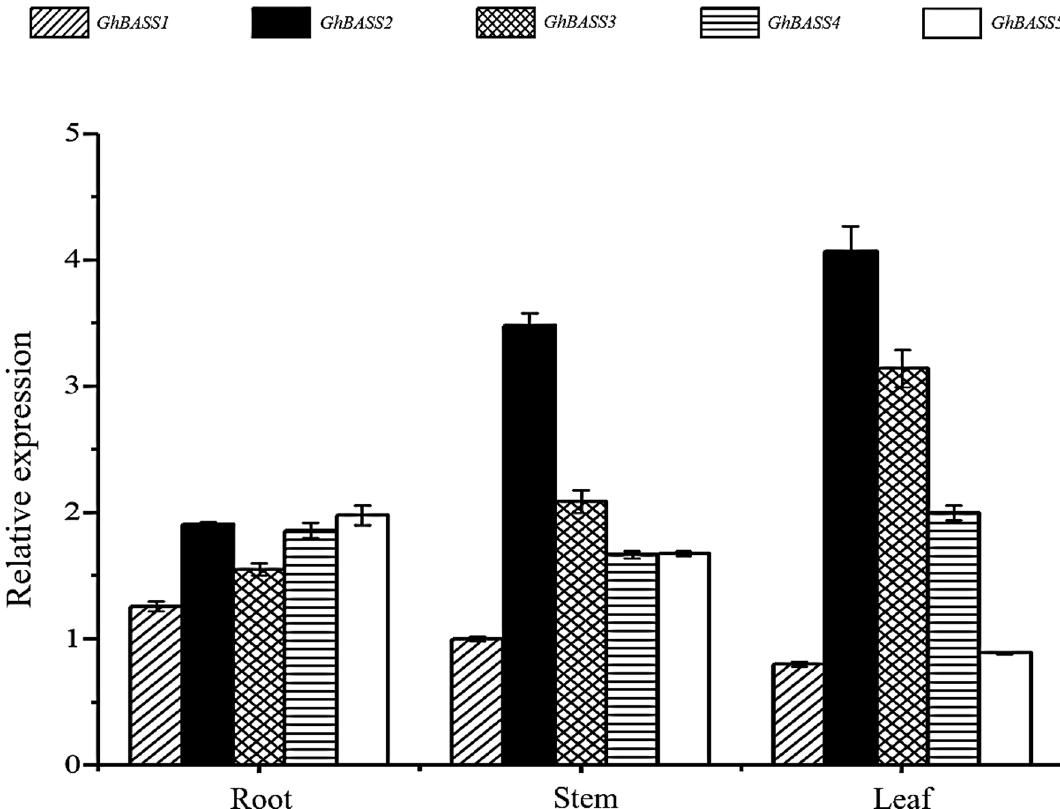
Figure 6. Expression patterns of GhBASSs in different tissues of cotton. Transcript levels were analyzed by qPCR and normalized to the GhUBQ7 gene (GenBank accession no. DQ116441). Means and standard errors were based on three idependent biological replicates. Error bars indicate standard error